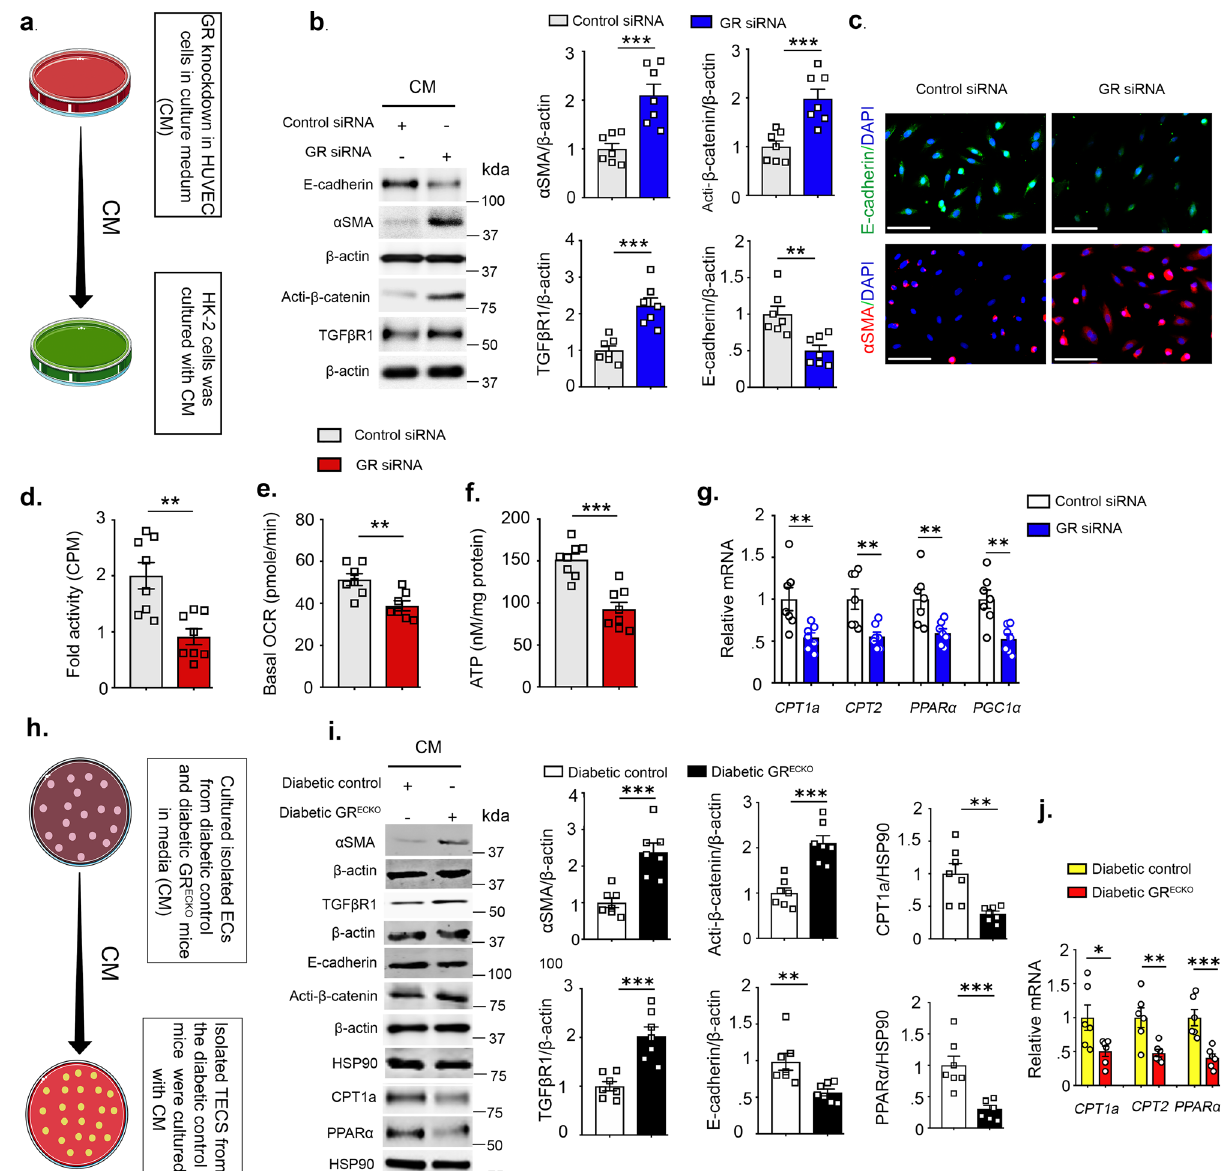
Fig. 7 GR loss in endothelial cells reprograms central metabolism in renal tubular cells. a Conditioned media experimental design. HUVECs were transfected with scrambled or GR siRNA; after 6 h, the medium was changed and cells were incubated for 96 h. The subsequently harvested media was transferred to HK-2 cells. b Representative Western blotting analysis of E-cadherin, α SMA, TGF β R1, and active β -catenin expression. N = 7 independent experiments. Representative blots from seven biologically independent samples/group were combined from four independent experiments. Densitometric analysis relative to β -actin is shown. c Immuno fl uorescence analysis of E-cadherin and α -SMA expression in conditioned medium-treated TECs. For